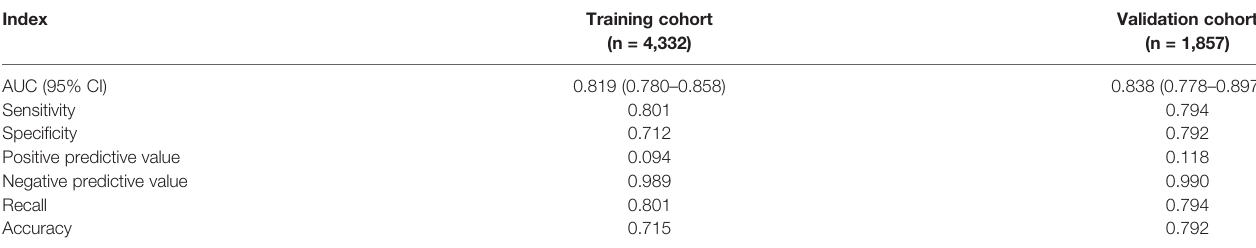
TABLE 3 | The performance of the nomogram for predicting SARS-CoV-2 breakthrough infection in vaccinated individuals.